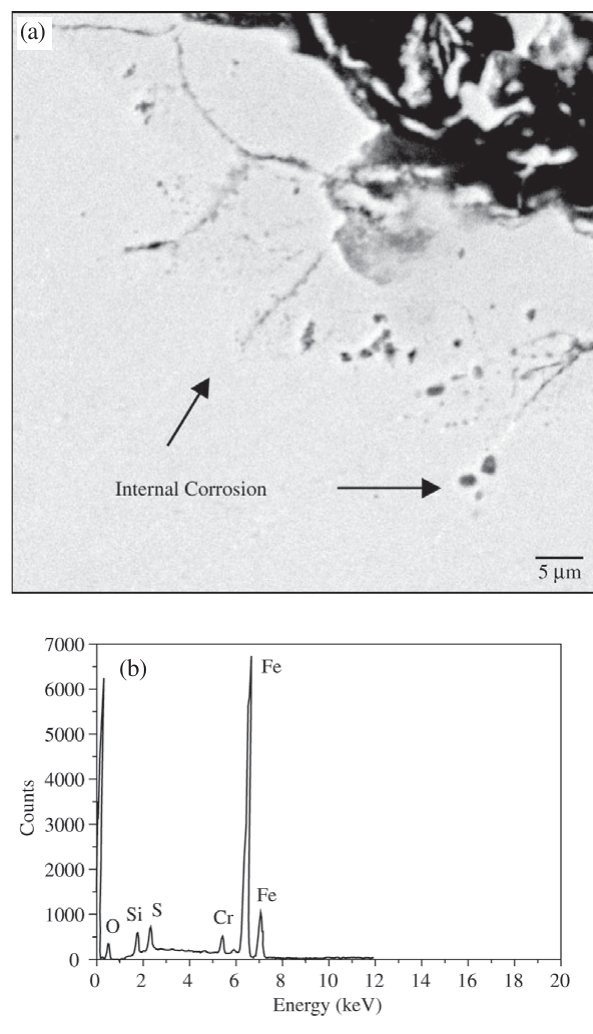
Figure 2. a) Cross-section of aluminum coated steel. The image shows the region immediately under the Al-Fe-Cr coating; b) EDS spectrum of one point inside the grain boundaries, revealing the presence of O and S.